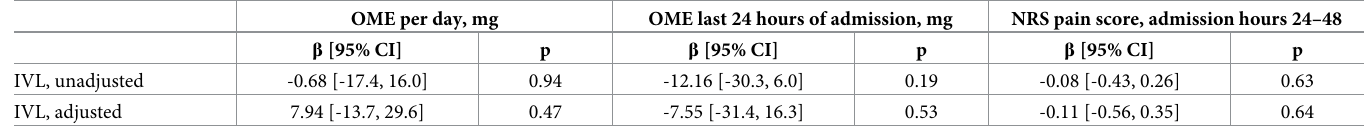
Table 4. Linear regression results estimating IVL associations with OME and pain measures: Unadjusted estimates (univariate) and multivariable estimates adjusted for injury severity score, hospital length of stay, and age (interaction). OME per day,